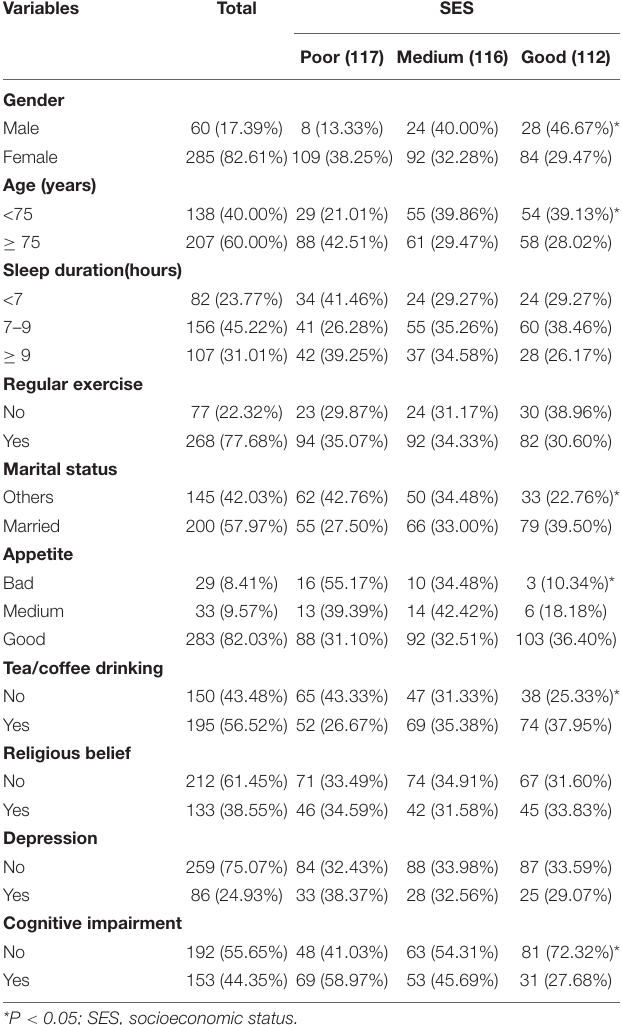
TABLE 1 | Sociodemographic characteristics of